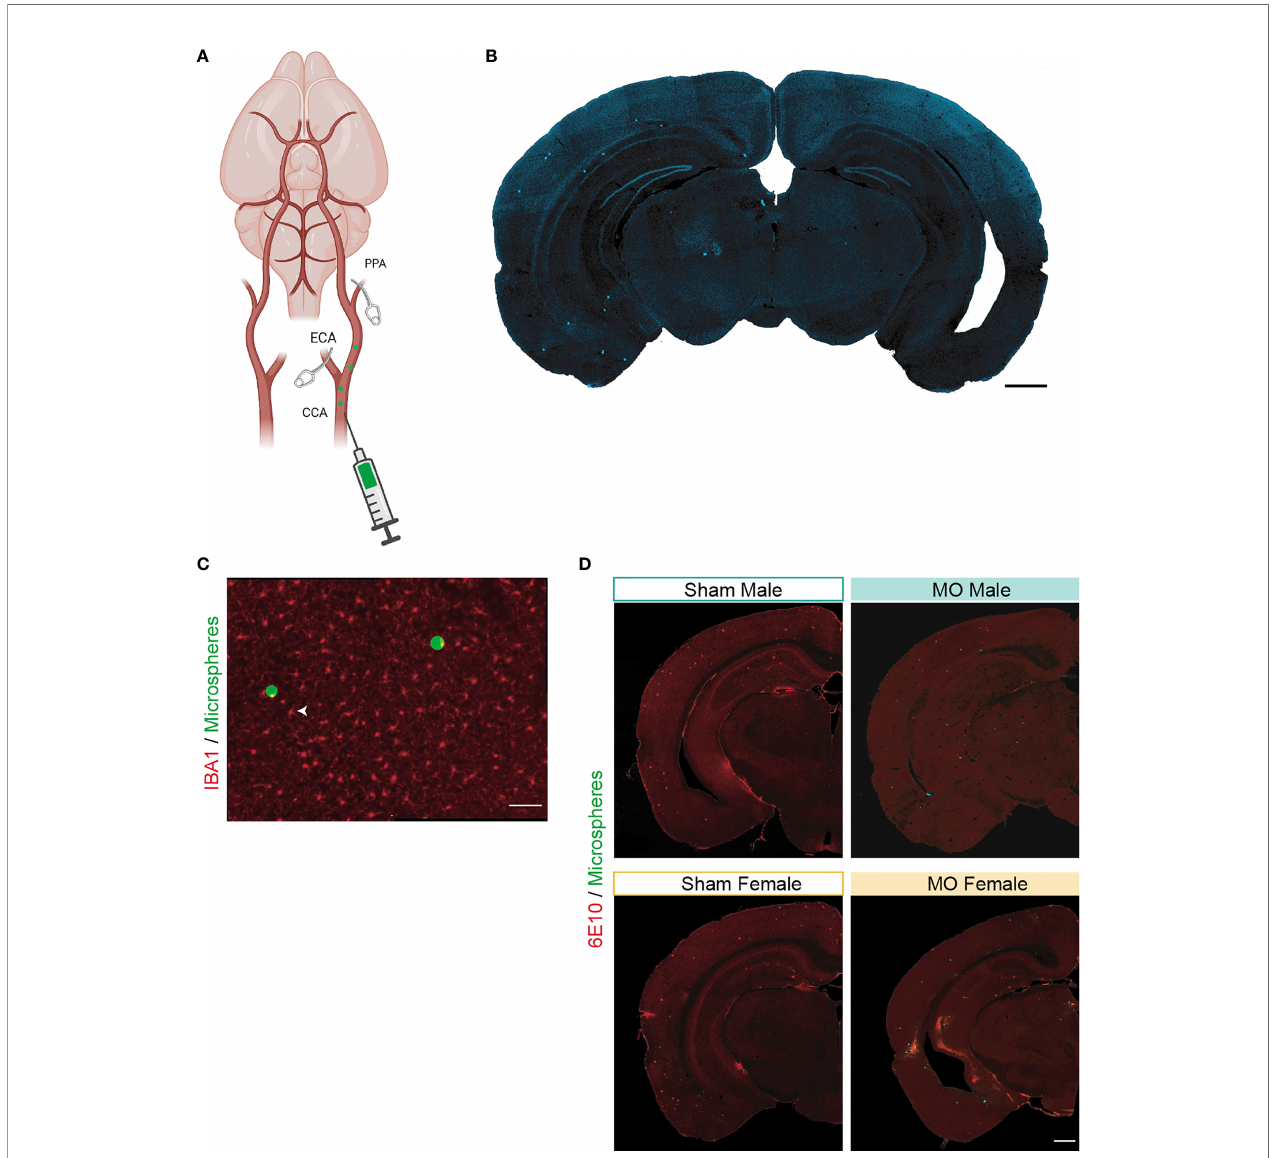
FIGURE 1 | Surgical procedure to induce multifocal microinfarcts in the mouse brain. (A) A scheme illustrating the surgical procedure to induce sporadic microinfarcts in the mouse brain. The external carotid artery (ECA) and the pterygopalatine artery (PPA) were temporarily blocked using a microvascular clip. Sterilized FITC-tagged microspheres (n=2500; 20 µm) were slowly injected into the left common carotid artery (CCA). The ECA and PPA were unblocked after the injection of microspheres. The procedure was performed, as previously described (55). Created with BioRender.com. (B) A representative image of the fl uorescent microspheres in a mouse brain. (C) A representative fl uorescent image of sterile microspheres surrounded by non-reactive microglia labeled using IBA1 1 month after surgery. (D) Representative fl uorescent images of 6E10 immunolabeled A b plaques (red) and microspheres (green) in the coronal brain sections of sham- and MO-operated male and female APP/PS1 mice. Scale bar = 500 µm (B, D) and 100 µm (C)